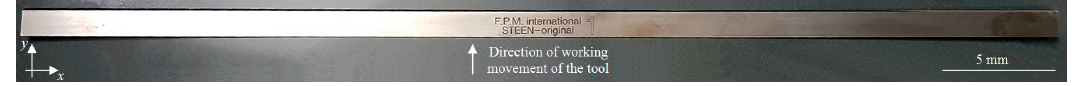
Figure 6. General view of a low-stiffness planar industrial cutting blade. Table 1. Characteristics of the industrial cutting blades used in the tests.